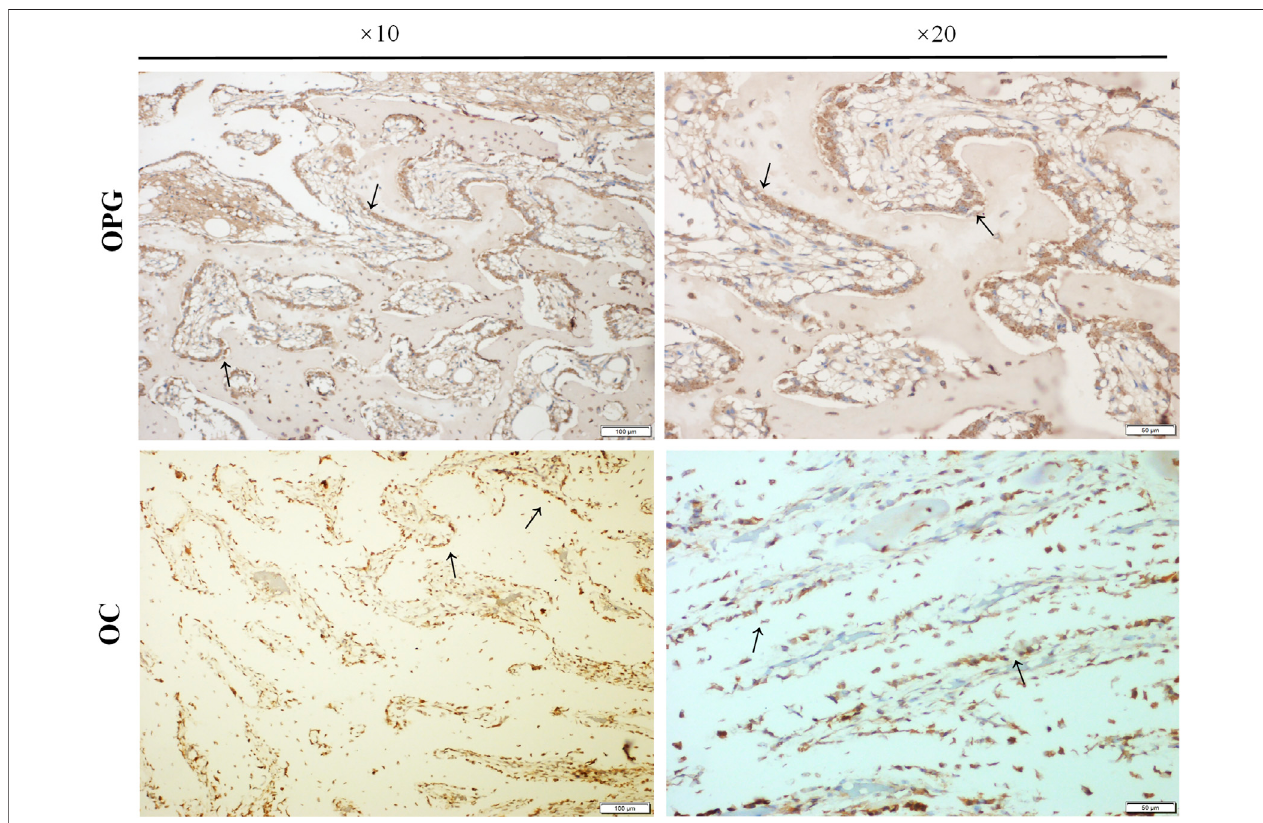
FIGURE 10 | The expressions of osteogenic markers. Paraf fi n sections of bone samples 21 days after the external cap implant grafted, and the expressions of osteogenic markers including Osteoprotegerin (OPG) and Osteocalcin (OC) were detected by immunohistochemical staining. The black arrows indicated positive expression in the columnar osteoblasts arranged in a